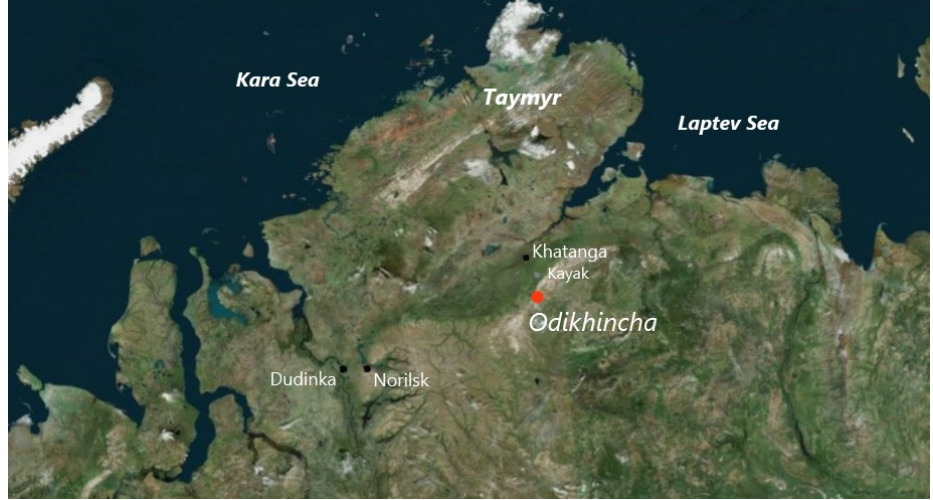
Figure 1. Location of Odichincha massif on the landscape image.